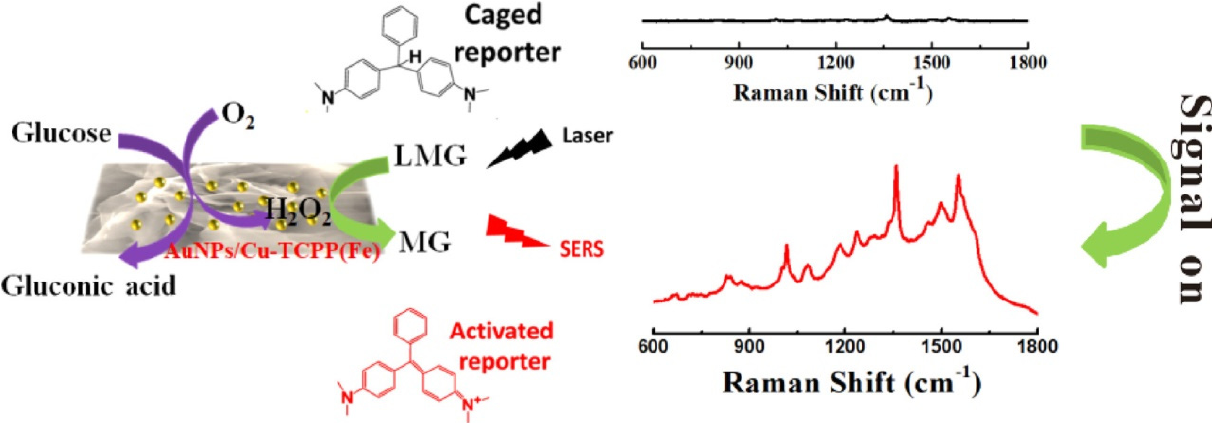
Figure 17. Schematic diagram of a 2D MOF − based, enzyme − free, SERS biosensor for glucose detection. Reprinted (adapted) with permission from [82]. Copyright 2020 American Chemical Society.